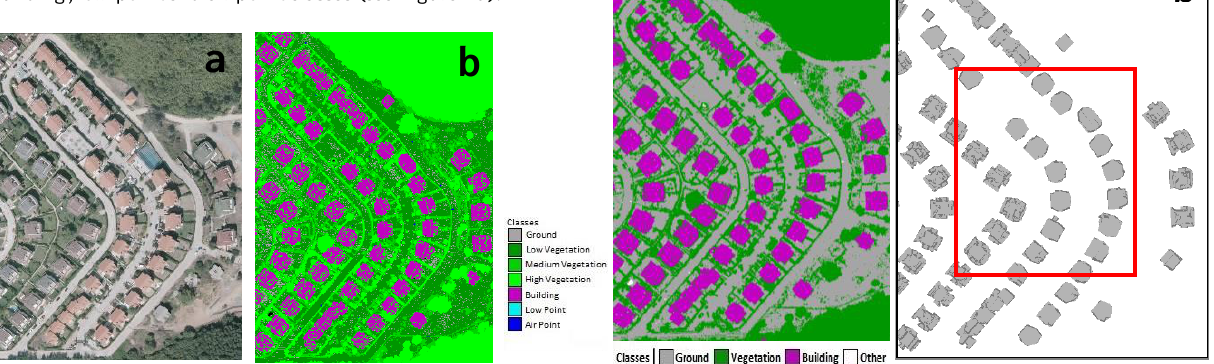
Figure 4. The ortho image of the study area (a) and roughly classified point cloud with standard parameters (b)